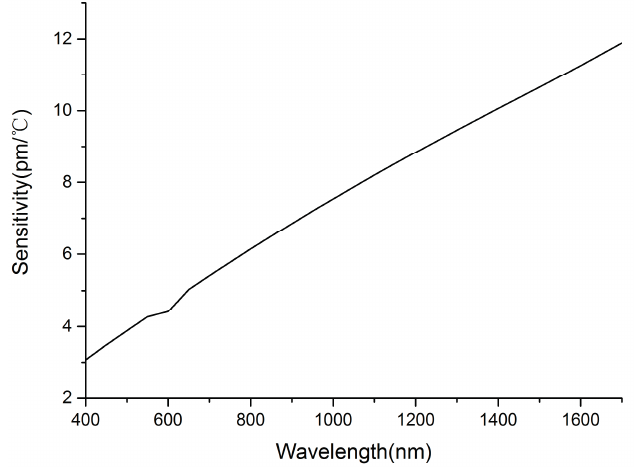
Figure 2. The simulated sensitivity dependence on probing